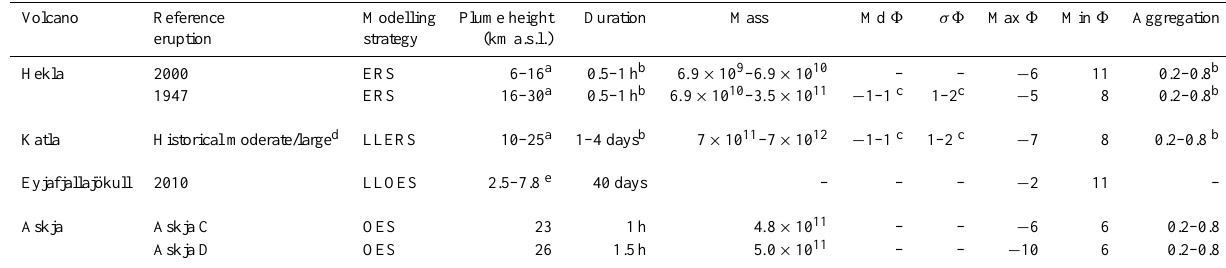
Table 3. Summary of ESP for all eruption scenarios. Volcano